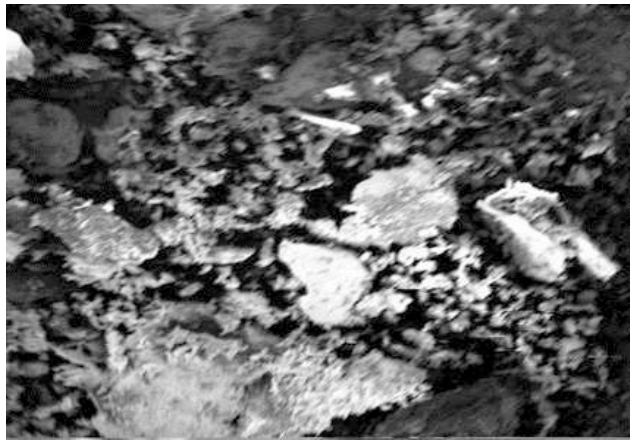
Figure 3. SEM image for CH-NPs/Se complexity.